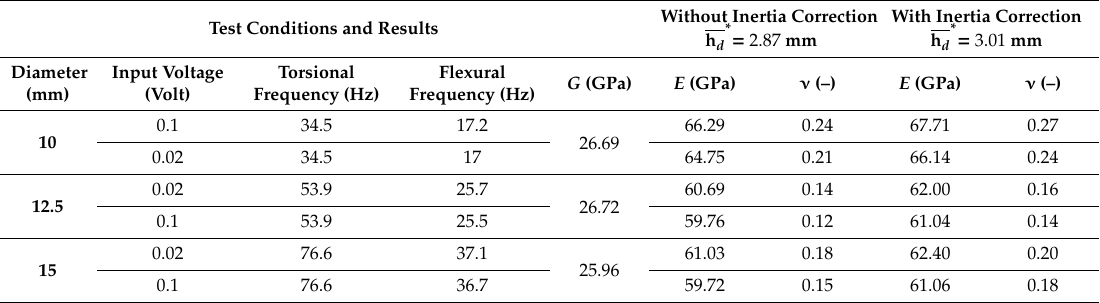
Table 2. Shear modulus, Young’s modulus, and Poisson’s ratio of calibration rod from the torsional and flexural resonant column